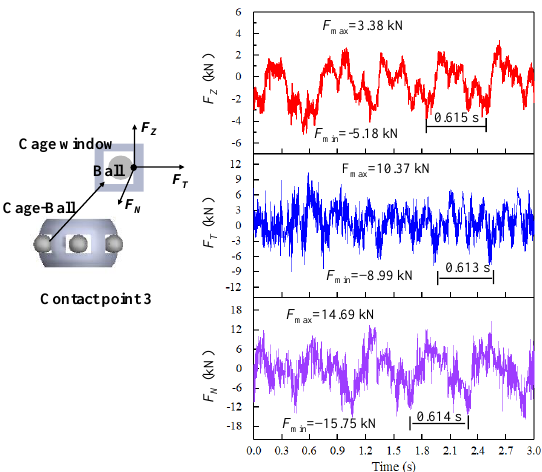
Figure 10. The variation of contact force between cage and ball. Table 3. Contact forces of cage at the time 1.51 s.